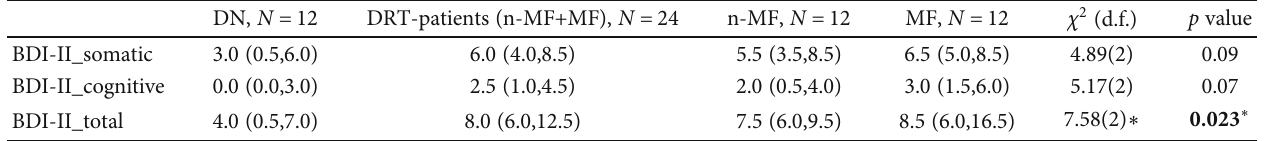
Table 5: Comparisons of BDI-II scores between the three groups of PD patients. DN, N = 12 DRT-patients (n-MF+MF), N = 24 n-MF, N =